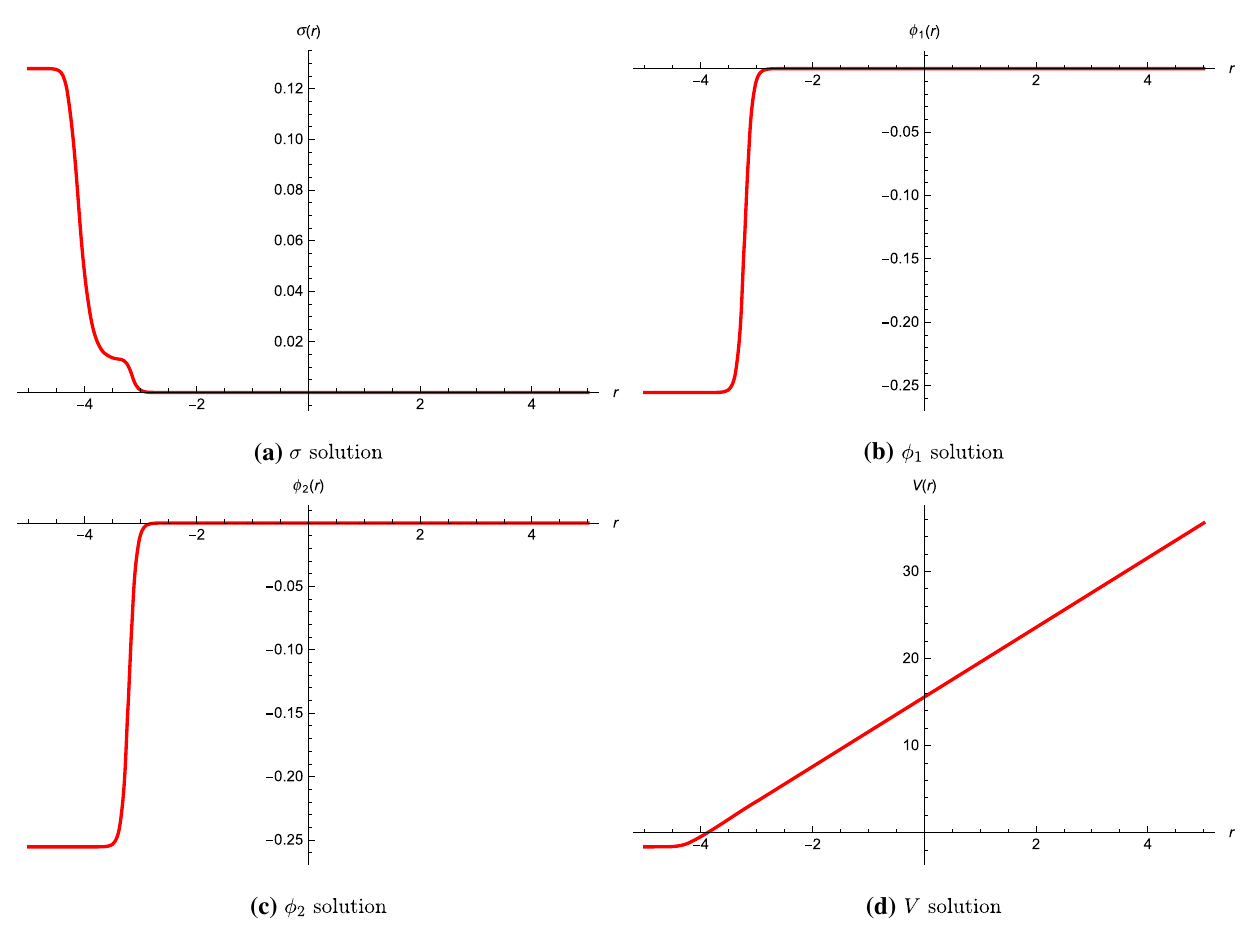
Fig. 14 An RG flow from SO ( 4 ) N = ( 1 , 0 ) SCFT to SO ( 3 ) N = ( 1 , 0 ) SCFT in six dimensions and eventually to two-dimensional N = ( 2 , 0 ) SCFT with SO ( 2 ) diag symmetry dual to AdS 3 × CH 2 solution